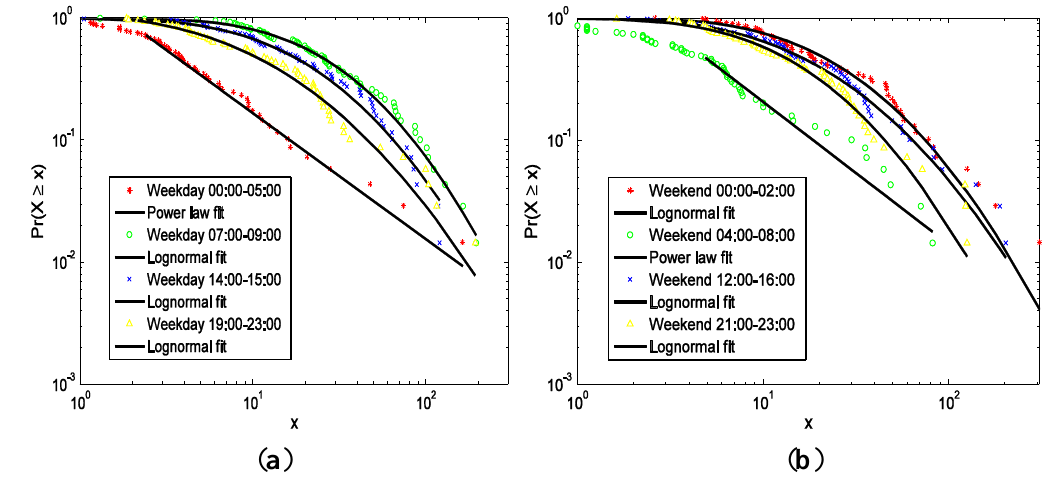
Figure 8. The plot for the heavy-tailed distribution of the intensity of human activities (Note: on an hourly basis, ( a ) shows weekdays; and ( b ) weekends; on a daily basis; ( c ) displays the plot from Monday to